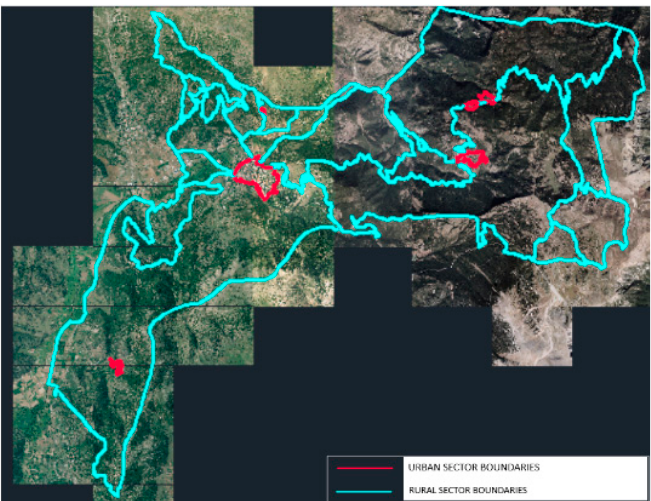
Figure 13. Division of rural sector into cadastral units and cadastral sectors. Source: [35]. Figure 14 shows an example of an advanced basemap.